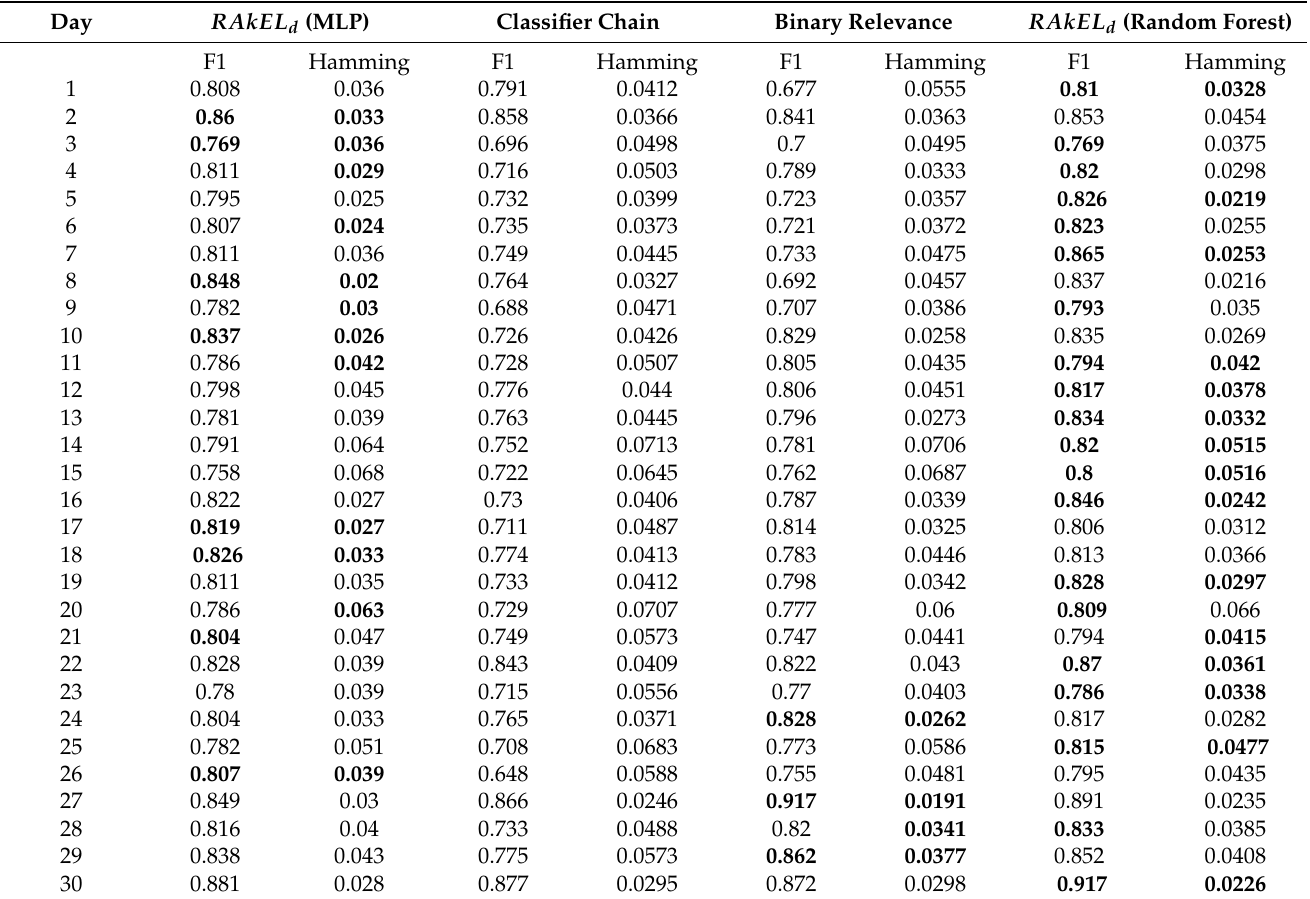
Table 8. Average F1 score and Hamming loss per day for House A. Best value per day can be seen in bold.